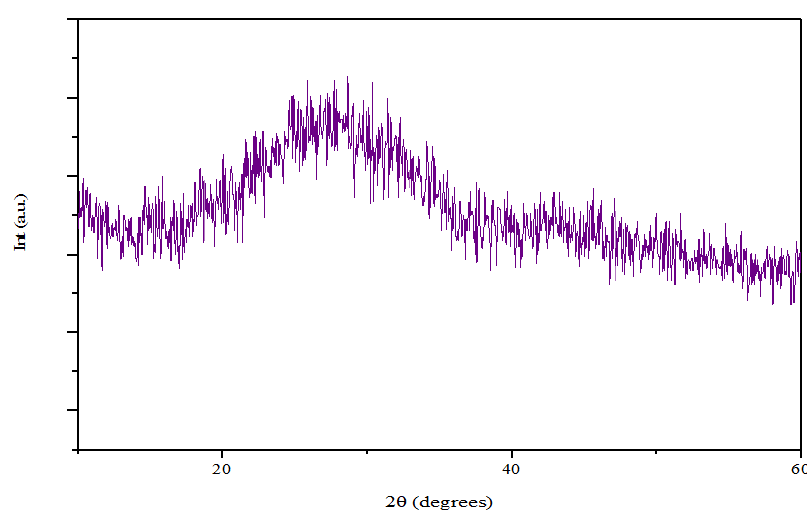
Figure 8. XRD diffractogram of E-glass fiber mat.